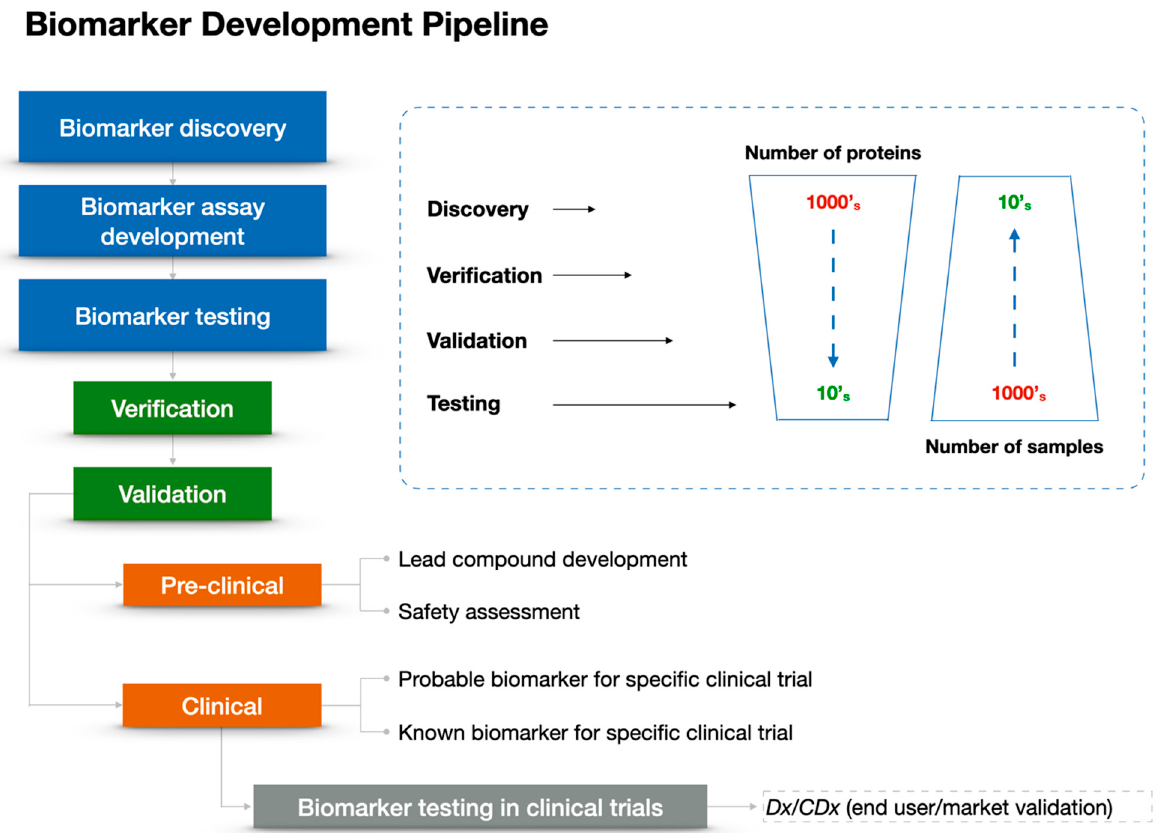
Figure 6. A Schematic of the Biomarker Pipeline. The main phases in the pipeline are presented including biomarkers discovery, verification, and validation stages. In addition, typical numbers of candidate biomarkers passing through each phase are indicated, highlighting the foregoing enigma, wherein, despite our capacity to generate long lists of candidates, only few make it to the final stages. Additionally, this illustrates the value of reverse biomarkers design process.